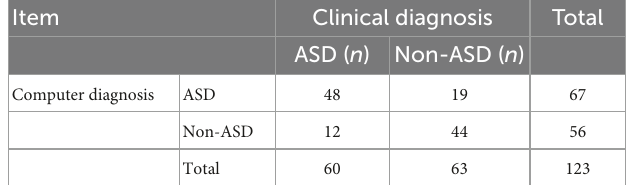
TABLE 4 Outcomes of ASD diagnosis based on the computer-rated results of RTN. Item